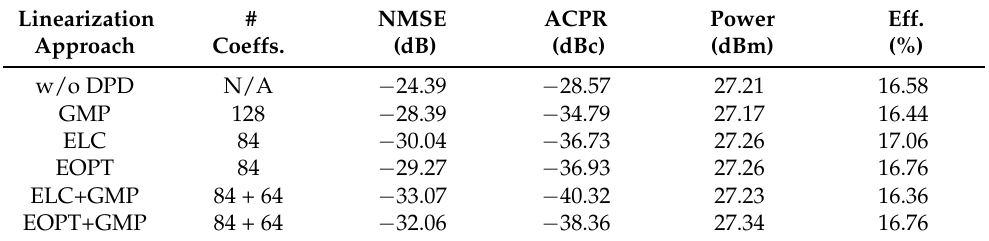
Table 1. ET PA experimental results with NR-60 MHz OFDM-like signal at band 7. Linearization # NMSE ACPR Power